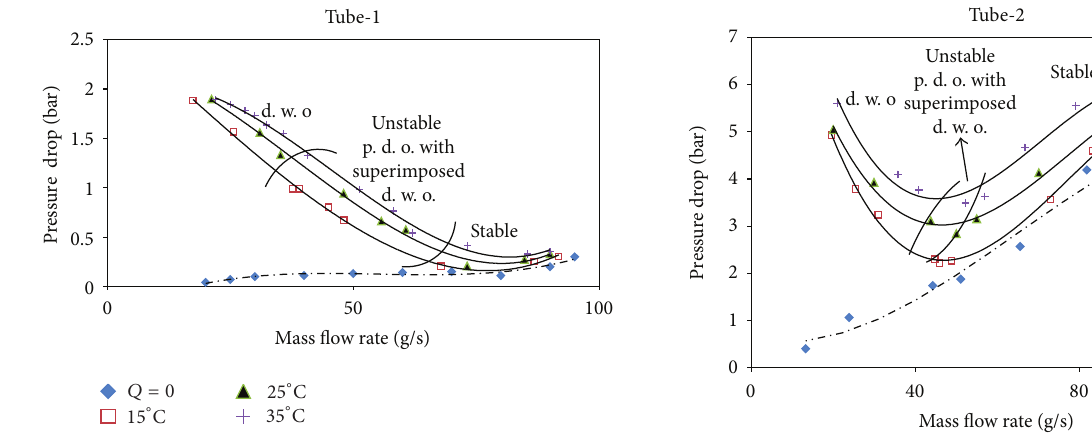
F 4: e steady state characteristic curves for Tube-1.